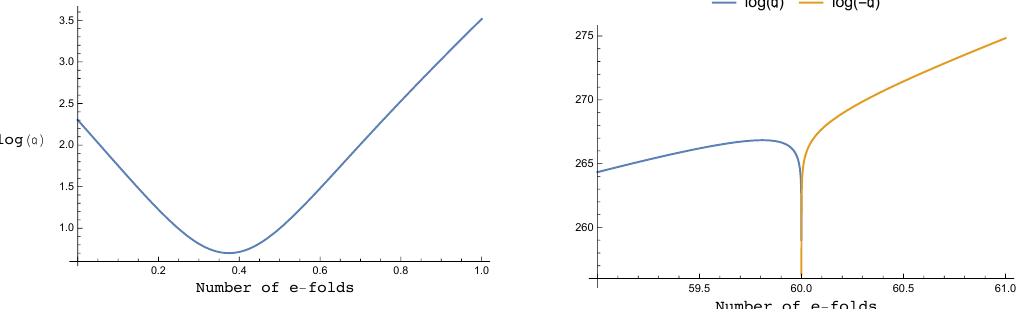
Figure 5. The plot to the left shows the behavior of the acceleration close to the bounce while the one to the right illustrates it towards the end of inflation. These plots were taken from Ref. [55] to which we direct for